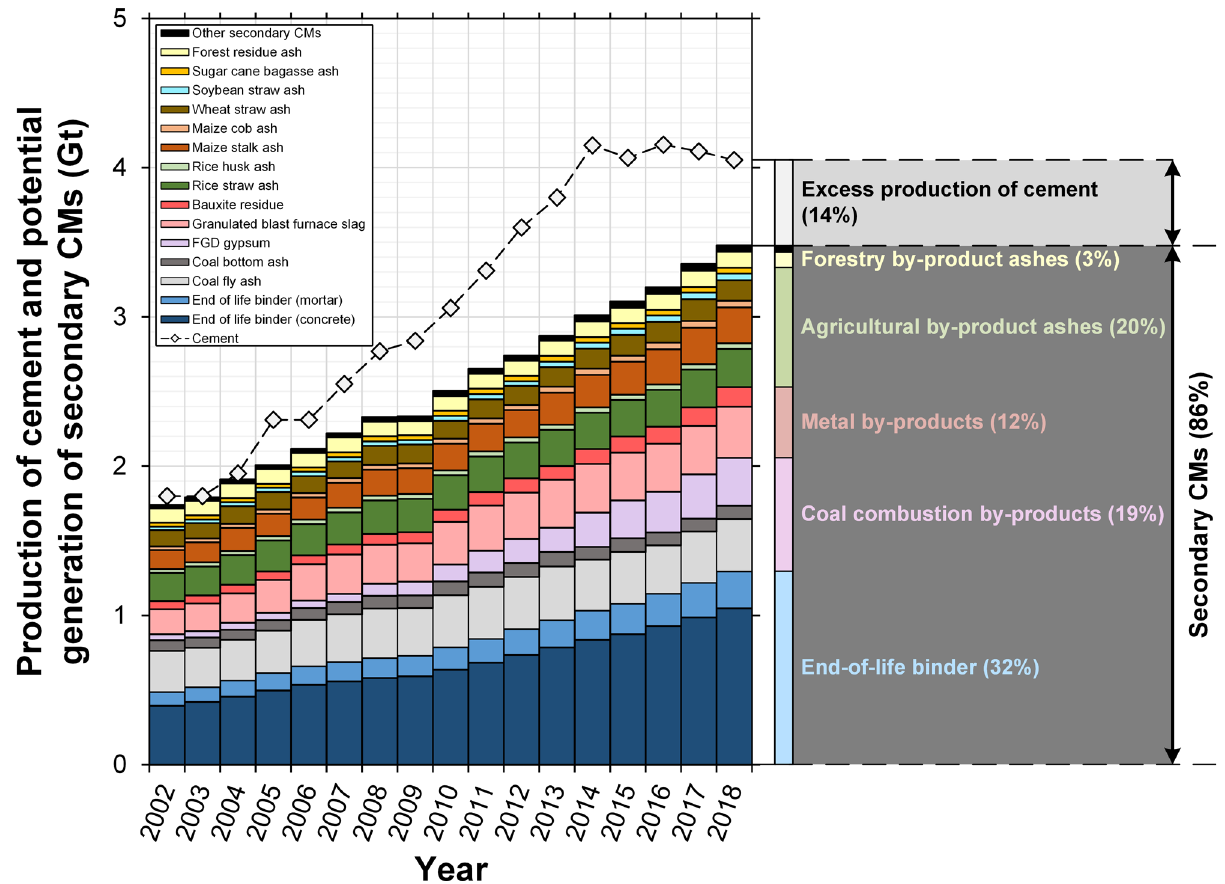
Fig. 2 | Global production of cement and generation of secondary cementitious materials (CMs). Cement production data are from 4 and secondary CMs data are modeled here (see